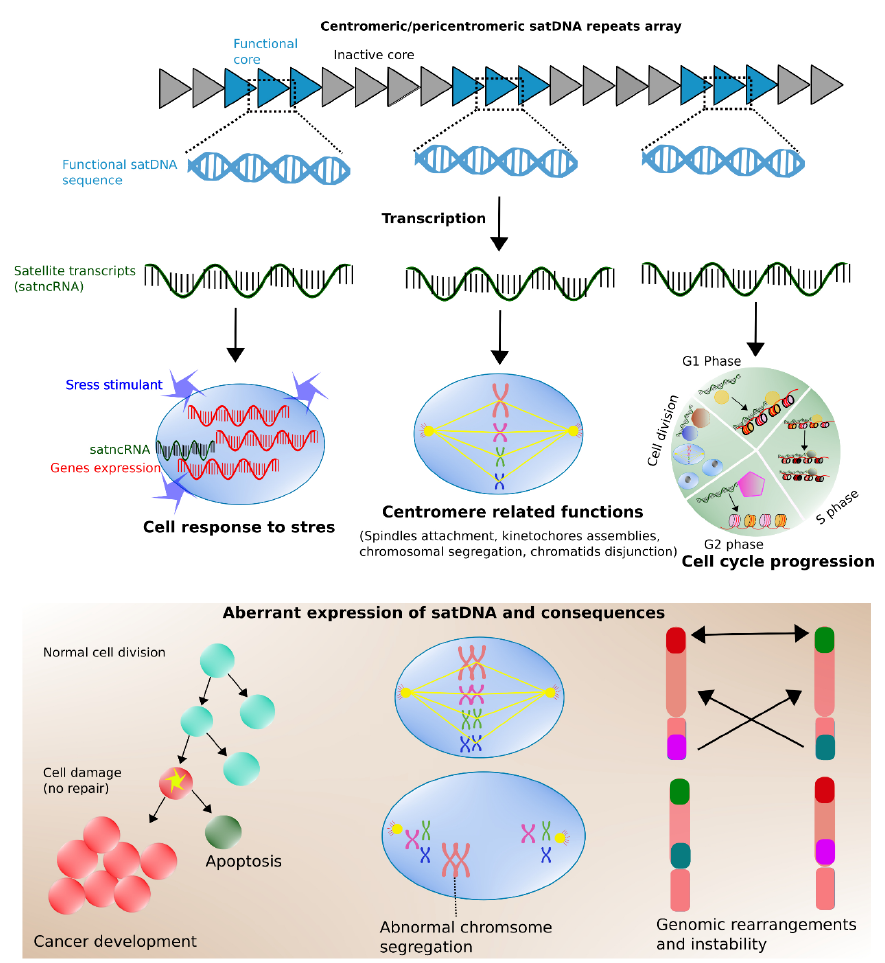
Figure 4. Diagrammatic summary of satellite DNA transcription highlighting various functional roles in cellular processes. The most studied transcripts of satellite repeats are those localized in the centromeres. The centromere / pericentromere core contains the active regions with satellite sequences that can be transcribed into satncRNA. These satncRNAs are associated with various functions. For example, during cellular stress, the satncRNA can regulate the expression of important genes, such as HSF1 (Heat Shock Factor 1), to produce nuclear stress bodies. In addition, satncRNA can also regulate the splicing of associated genes that are vital in stress responses. More importantly, satncRNA transcripts have been linked with centromere-related functions and cell-cycle progression. During the G1 phase, the satncRNA can facilitate the loading of CENP-A (yellow circle) at centromeres, which is distributed to every daughter strand in the S phase. In the G2 phase, the satncRNA transcripts form associations with SUV39H1 (purple pentagon) before initiation of cell division. During mitosis, satncRNA binds with SGO1 and AURORA B proteins, and assists in kinetochore assembly, spindle attachment, and chromosome segregation-related